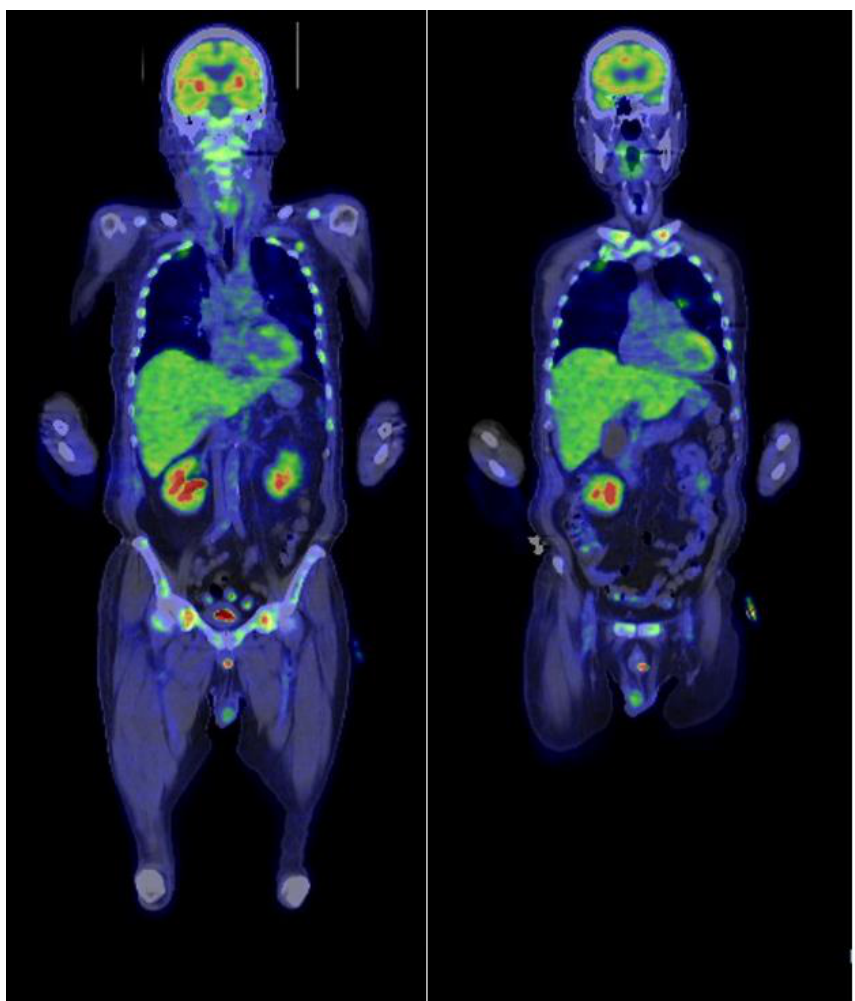
Figure 2. A lesion exhibiting high 18-FDG uptake (SUVmax, >4) was detected in the bones (clavicle, humerus, spine, rib, pelvis, and femur) and spleen. 18-FDG, humerus, spine, rib, pelvis, and femur) and spleen. 18-FDG, 2-deoxy-2-(fluorine-18)-fluoro-D-glucose; 2-deoxy-2-(fluorine-18)-fluoro-D-glucose; PET, positron emission tomography; SUVmax, maxi- PET, positron emission tomography; SUVmax, maximum standard uptake mum standard uptake value.